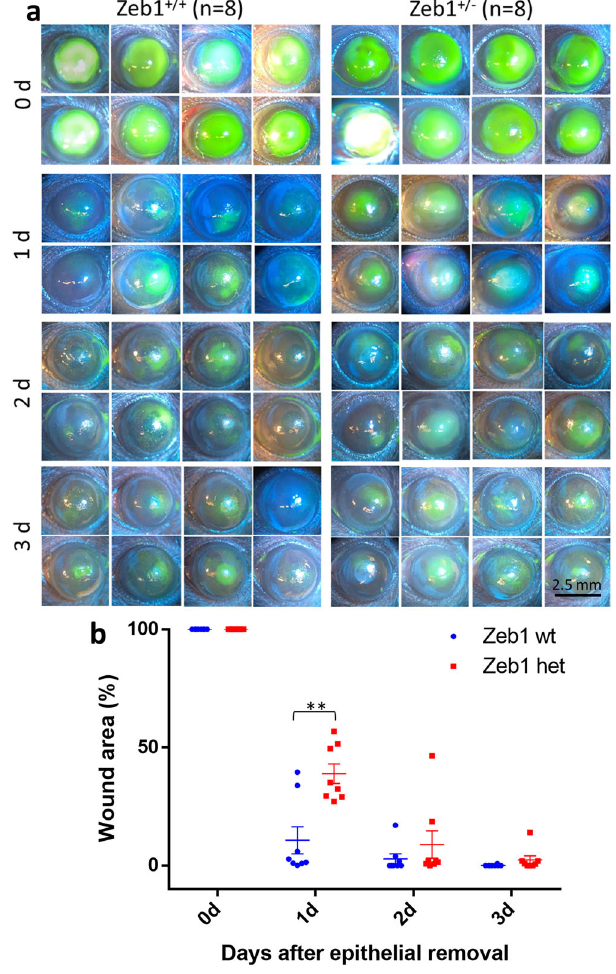
Fig. 1 Monoallelic Zeb1-KO delays the recovery of the debrided epithelium. a Images of the fl uorescein-stained corneas of both Zeb1 + / + and Zeb1 + / − mice over period of 3 days after the epithelial debridement. b The debrided areas were measured with the software ImageJ and analyzed by the software GraphPad Prism. wt, Zeb1 + / + ; het, Zeb1 + / − ; ** p ≤ 0.01; n , the number of corneas used. The bars are the mean ± standard error